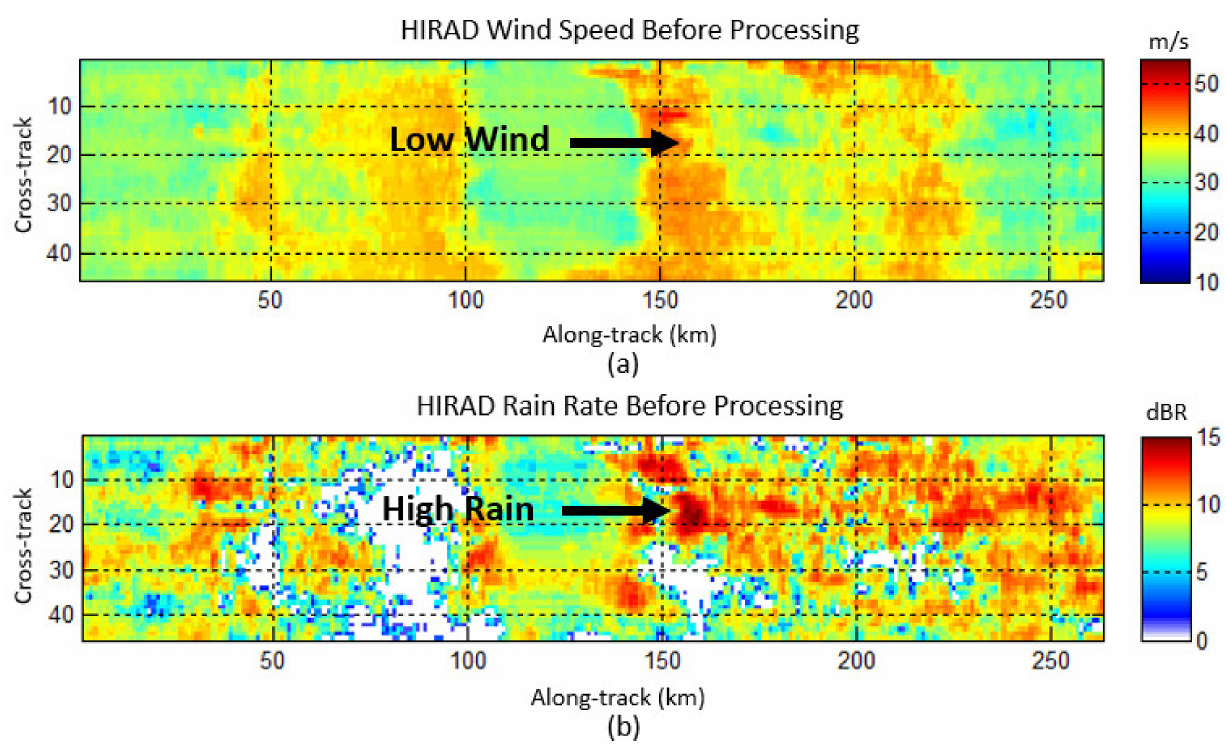
Figure 11. HIRAD-retrieved ( a ) WS (m/s) and ( b ) RR (mm/h) for Hurricane Gonzalo Leg 4. Based upon a number of observations, it is concluded that high rains cause unaccept- able error in the WS retrievals. Therefore, invalid regions are subjectively flagged where HIRAD wind speed retrievals are sharply lower when measuring rain and replaced by interpolated values from the surrounding pixels. Next, using these interpolated WS, a constrained retrieval is applied by finding the RR that minimizes the cost function, given the WS. The resulting WS and RR are shown in Figure 12a,b respectively, where the winds in Figure 12a are smoother. To interpolate flagged winds, valid wind speed retrievals are gridded onto a storm-relative polar grid, which naturally averages nearby points together due to the gridding. Flagged data is interpolated using surrounding points in polar coor- dinates and then interpolated back to the HIRAD pixel locations. This binning naturally averages nearby wind speed measurements, producing a smoother and more robust